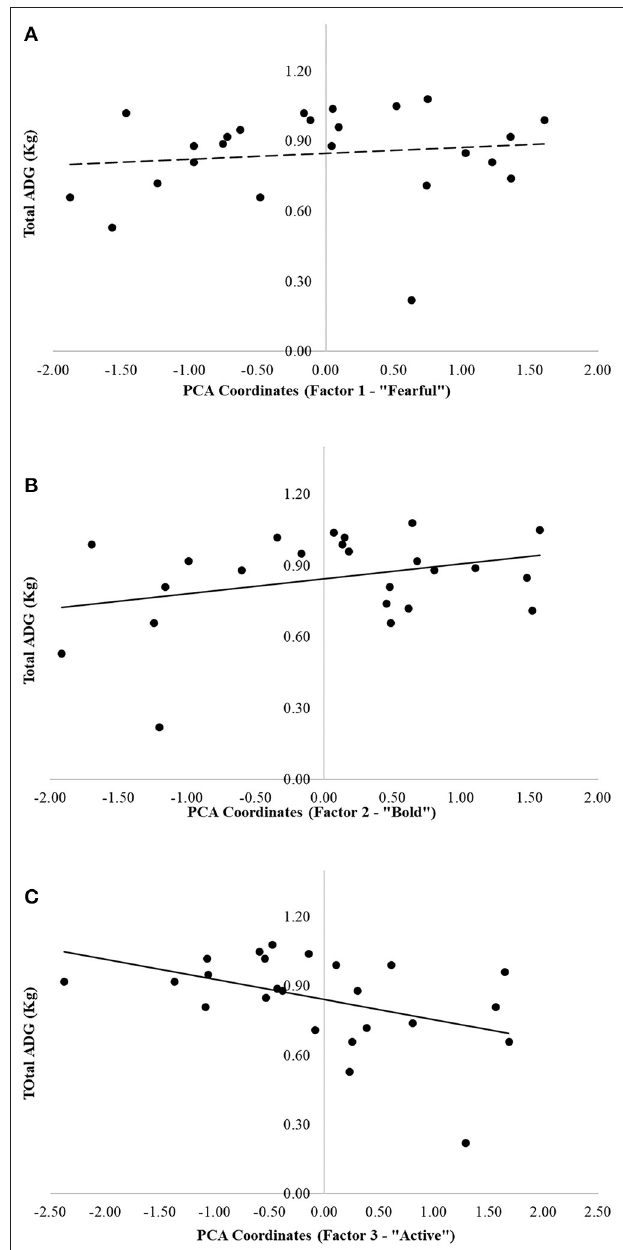
FIGURE 7 | (A–C) Distribution of individual calf average daily gain (ADG) from birth until 2-weeks after weaning (Total ADG) plotted against each factor from the principal component analysis of the traditional personality tests: (A) Factor 1 (“Fearful”), (B) Factor 2 (“Bold”), and (C) Factor 3 (“Active”). The linear regression trendline is presented for each plot (solid black line = significant regression, P < 0.05; dashed line = non-significant regression, P > 0.05).